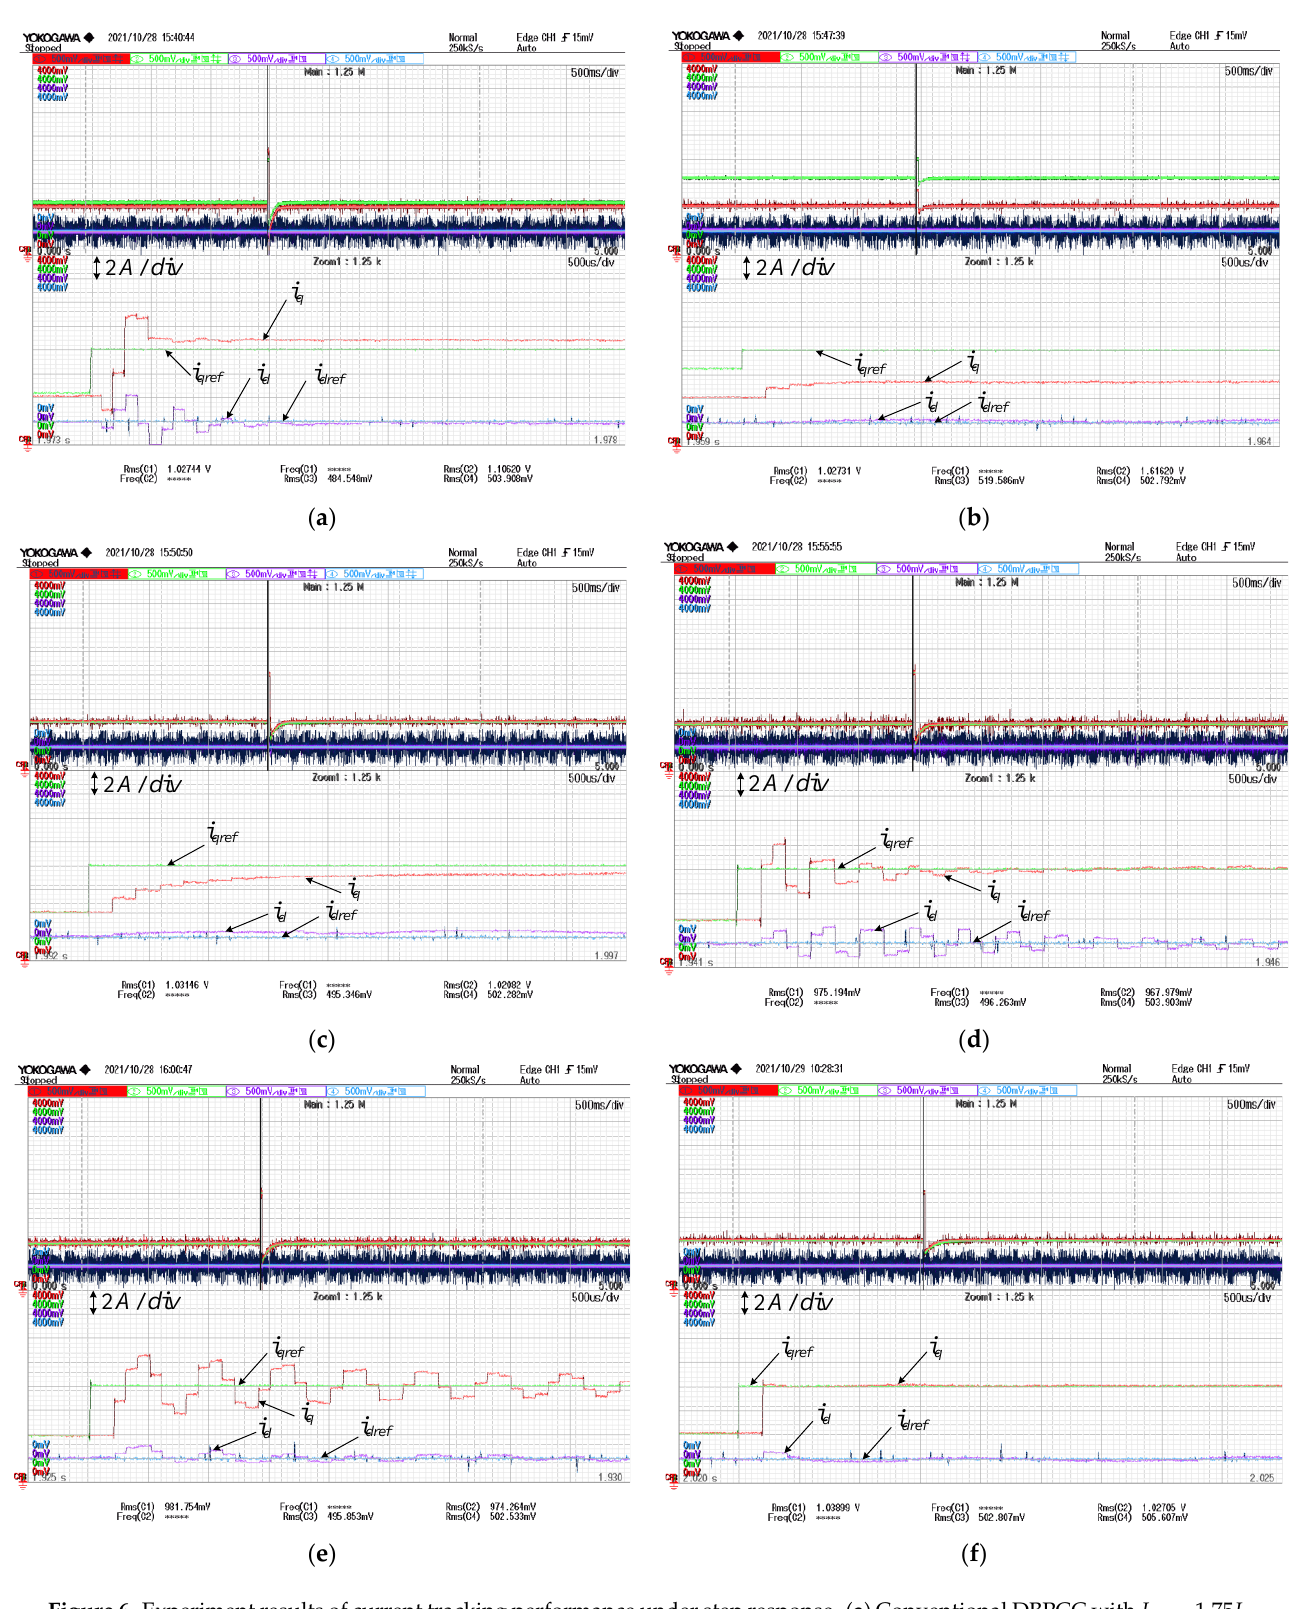
Figure 6. Experiment results of current tracking performance under step response. ( a ) Conventional DBPCC with L 0 = 1.75 L , R 0 = 5 R , ψ f 0 = 0.3 ψ f ; ( b ) conventional DBPCC with L 0 = 0.5 L , R 0 = 0.1 R , ψ f 0 = 0.6 ψ f ; ( c ) ESO-based DBPCC with L 0 = 0.3 L ; ( d ) ESO-based DBPCC with L 0 = 1.55 L ; ( e ) PI controller; ( f )